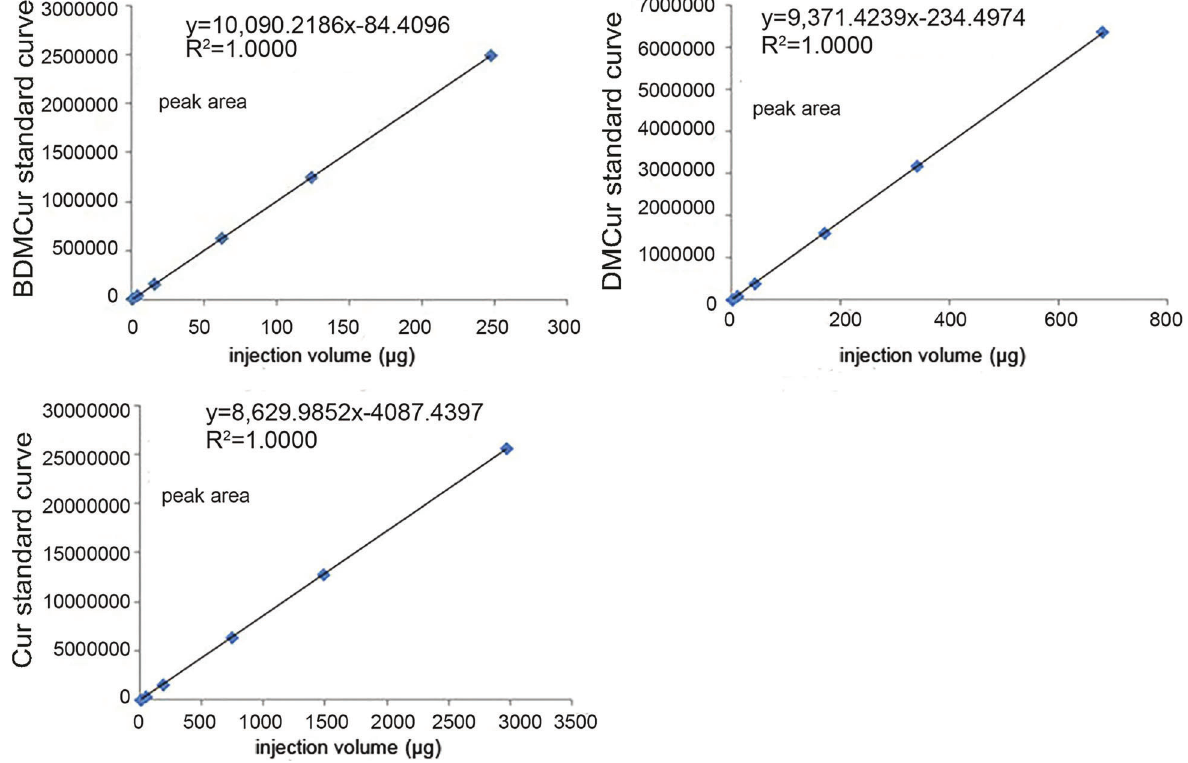
Figure 2. Linear relationship of bisdemethoxycurcumin (BDMCur), demethoxycurcumin (DMCur) and curcumin (Cur).